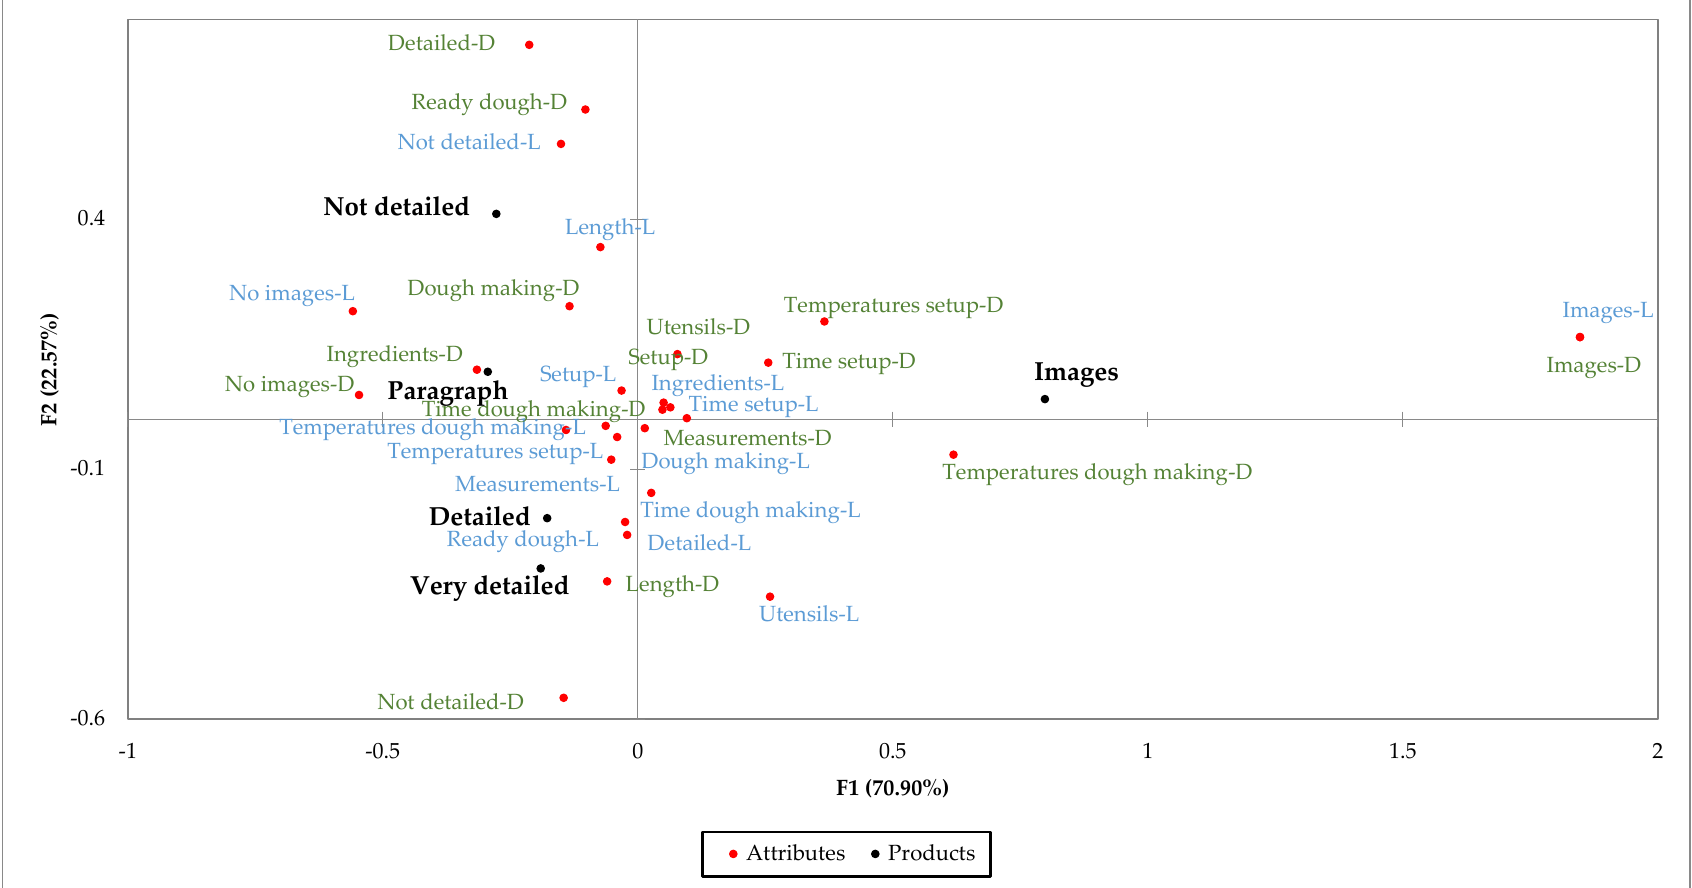
Figure 7. Correspondence analysis factor map representing five corn recipes and 15 liking (L) and disliking (D) factors. This factor map represents 93.47% of the total variance, with factor 1 contributing to 70.90% and factor 2 covering 22.57% of the variance.